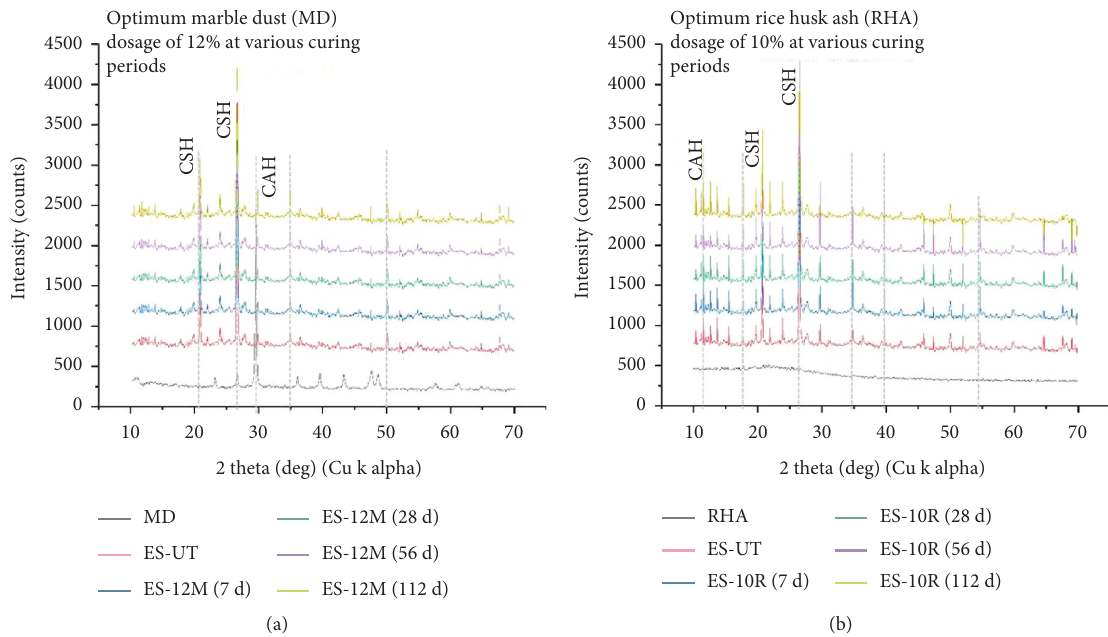
Figure 12: XRD analysis of stabilizer material, untreated expansive soil, and treated soil samples cured at 7, 28, 56, and 112 days for (a) 12% MD and (b) 10% RHA dosage.